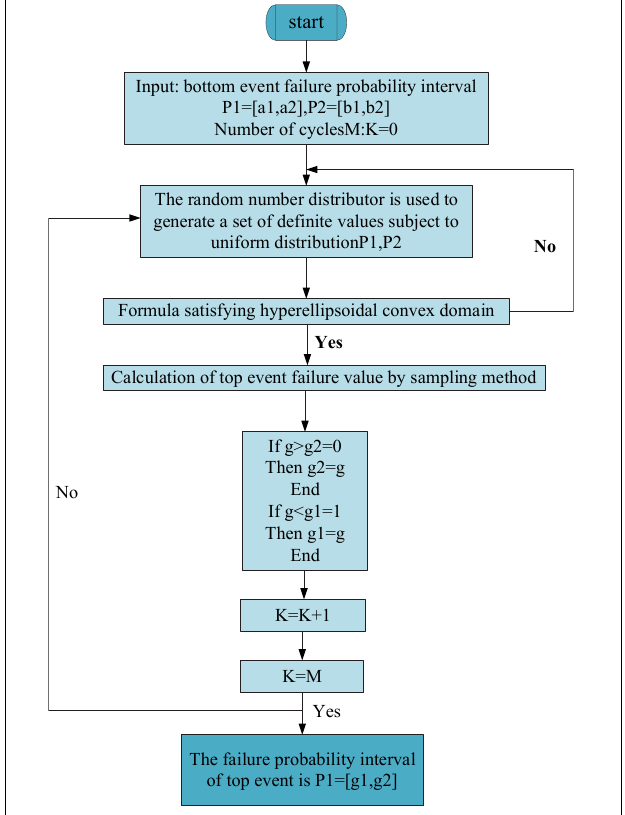
FIGURE 18 | Monte Carlo sampling flowchart under the hyper-ellipsoid model.